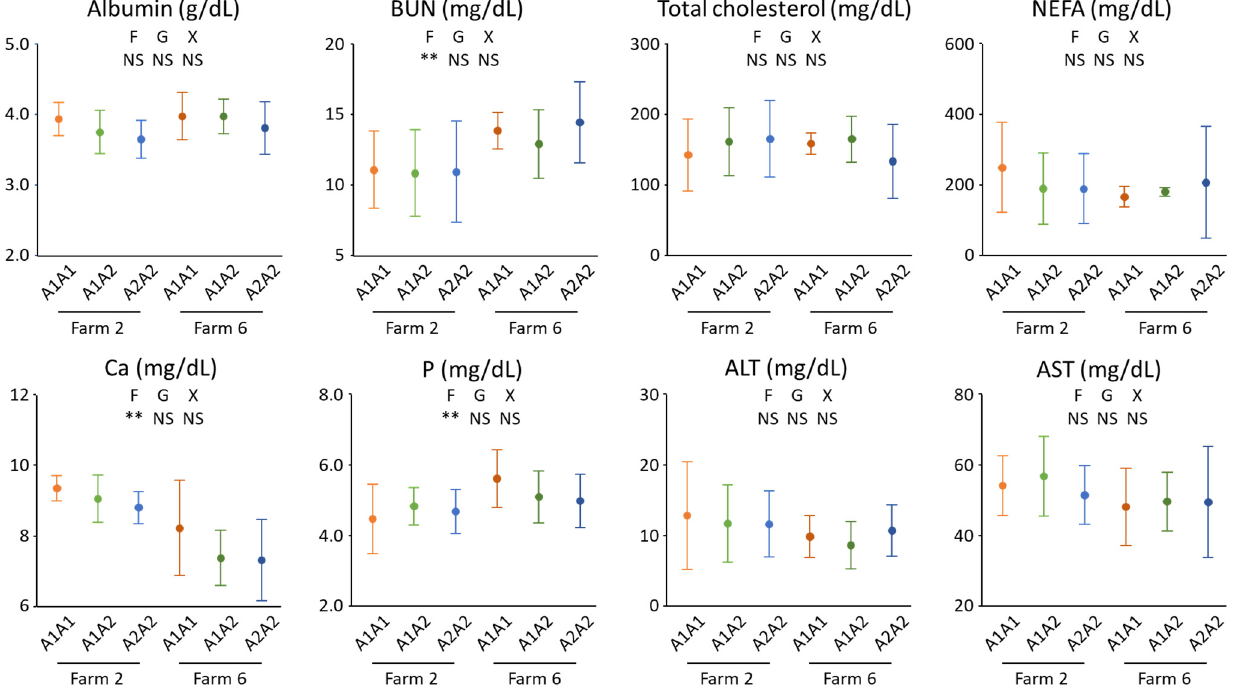
Figure 1. Plasma concentrations of albumin, urea nitrogen (BUN), total cholesterol, non-esterified fatty acid (NEFA), calcium (Ca), phosphorus (P), aspartate aminotransferase (AST), and alanine aminotransferase (ALT) of the Jersey cows from two farms in Okayama Prefecture, a western region of Japan. On each farm, blood samples were collected from six, ten, and ten cows of the A1A1, A1A2, and A2A2 β -casein variants, respectively. A two-way analysis of variance was performed to examine the effect of farm (F), genotype (G), and their interaction (X). NS; not significant ( p ≥ 0.05), *; p < 0.05, **; p <